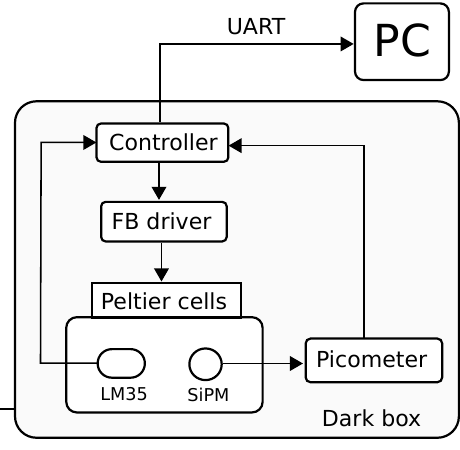
Figure 1. Experimental setup for measuring the SiPM dark current in darkness conditions. The SiPM is positioned in the aluminium holder inside the dark box. A PID controller sets the holder temperature via two Peltier cells with a full bridge (FB) driver. The controller sends the data to a computer via a UART (universal asynchronous receiver–transmitter) port.